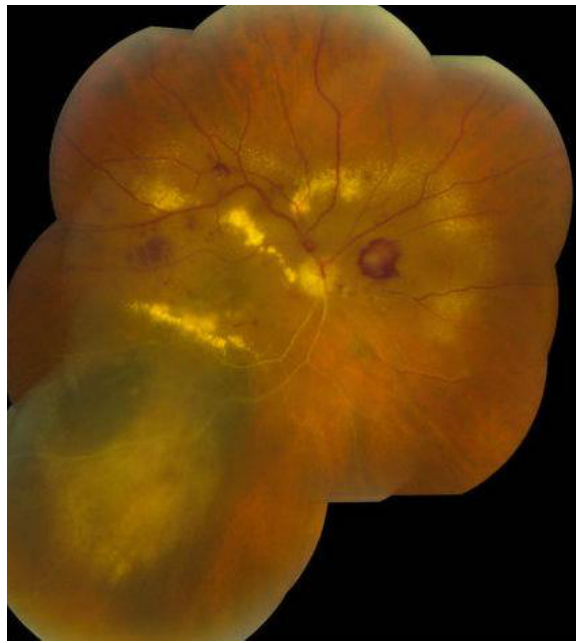
Figure 2. Darkly pigmented melanoma.